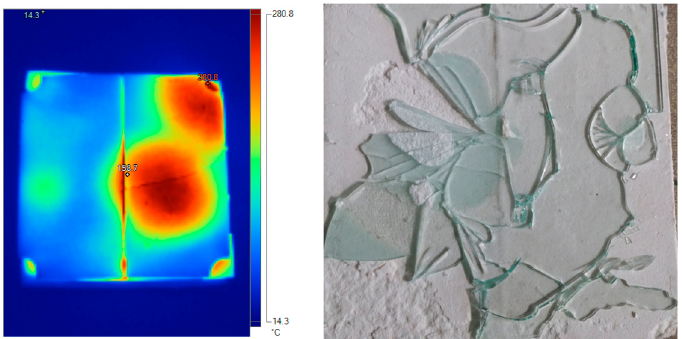
Figure 7. Experimental results obtained at a temperature of 200 °C and heating rate 20 °C/min. Temperature distribution ( left ) and cracks on the glass ( right ).